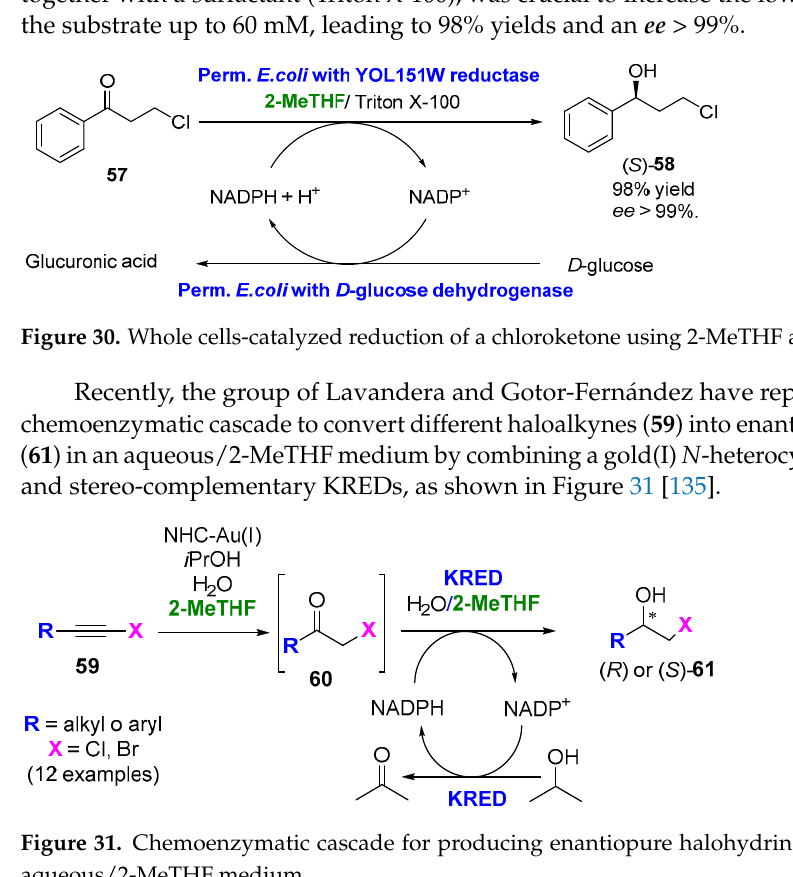
Figure 29. KRED-catalyzed reduction of β -ketodioxinones ( 55 ) in biphasic media.